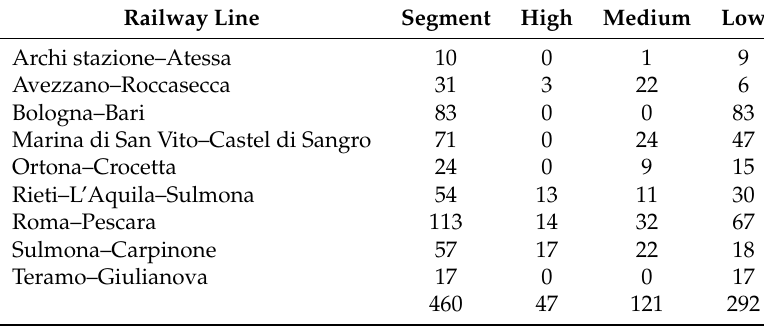
Table 13. Distribution of the segments inside the three classes of